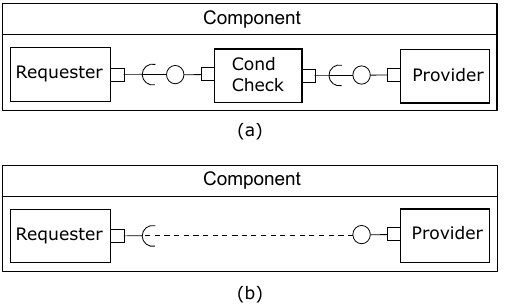
Figure 19. Blocking or forwarding requests depending on the runtime condition: ( a ) Existing design: Using an intermediate object for conditionally blocking the request. ( b ) Updated design: Using an enhanced connector that can conditionally block the